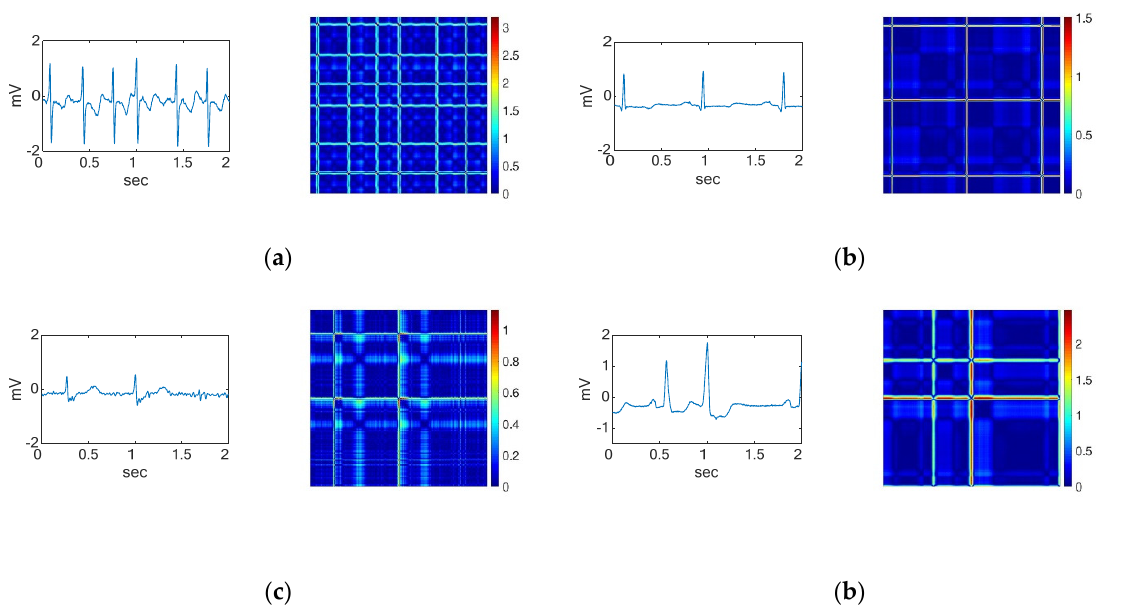
Figure 3. Waveforms and their corresponding RPs of ( a ) AF, ( b ) normal, ( c ) PAC, and ( d ) PVC, which are the four ECG arrhythmia types discriminated in the second stage.